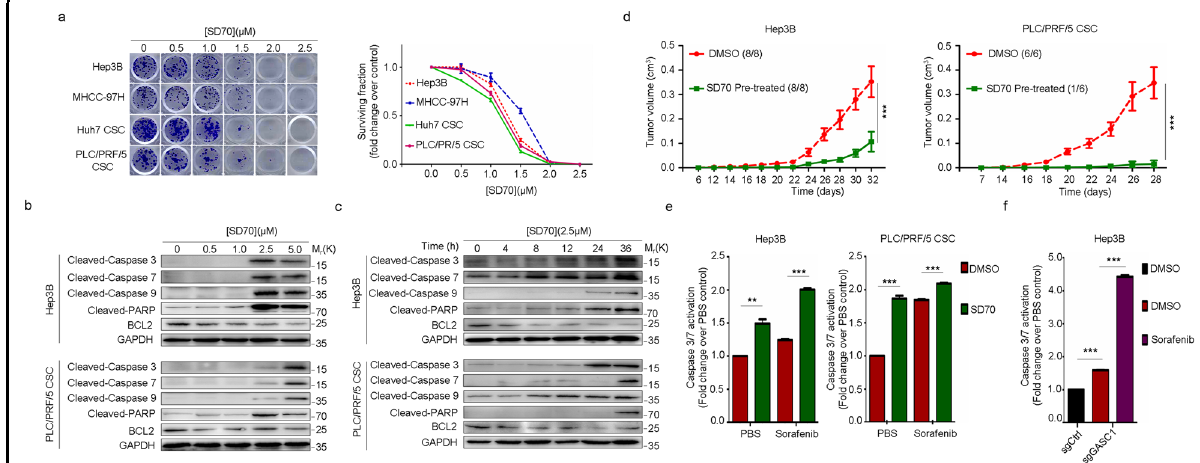
Fig. 6 GASC1 inhibitor SD70 impairs clonogenic survival of liver cancer cells and tumor growth in vivo in xenograft models of HCC. a Clonogenic survival and growth of Hep3B, MHCC-97H, Huh7 CSC and PLC/PRF/5 CSC cells after treatment with increasing concentrations of SD70, as assessed by colony-formation assays (left panel), and quanti fi cation of the surviving fraction values for each condition, determined from the number of colonies for each condition relative to those in the blank control (right panel). Data are presented as mean ± SEM of three independent experiments. b , c Immunoblotting analysis of the indicated protein levels in Hep3B and PLC/PRF/5 CSC cells treated with increasing concentrations of SD70 ( b ), or 2.5 μ M SD70 for increasing amount of time ( c ). d Xenograft tumor growth of subcutaneously implanted Hep3B and PLC/PRF/5 CSC cells pre-treated with SD70 or vehicle control. Tumor growth was monitored at the indicated time points and tumors were dissected at the endpoint. Data are presented as mean ± SEM. The number of treated mice ( n ) per group was shown. Data from the last time point was analyzed by two-tailed unpaired t test. (*** P < 0.001). e , f Caspase-3/7 activation levels in Hep3B and PLC/PRF/5 CSC cells following 48 h of incubation with sorafenib, in the presence or absence of 2.5 μ M SD70 ( e ) or under the GASC1 knockout condition ( f ). Data are presented as mean ± SEM from three independent experiments. Data were analyzed by two-tailed unpaired t test, ** P < 0.01; *** P <